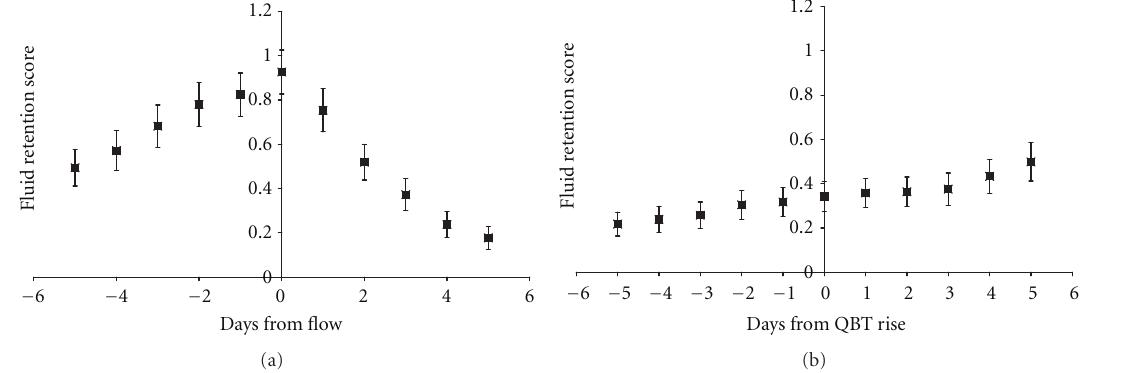
∗ Luteal lengths only for cycles that were ovulatory by QBT.